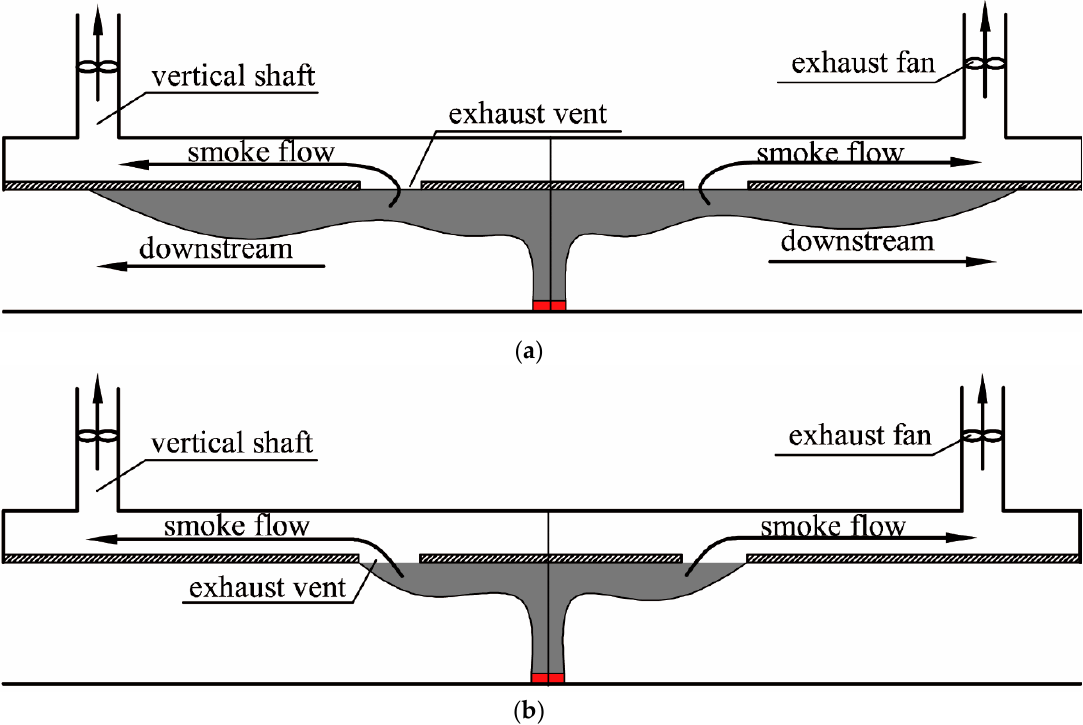
Figure 3. Smoke di ff usion under di ff erent exhaust volumetric flow rates in tunnel. ( a )small exhaust Figure 3. Smoke diffusion under different exhaust volumetric flow rates in tunnel. ( a )small exhaust volumetric flow rate; ( b ) critical exhaust volumetric flow volumetric flow rate; ( b ) critical exhaust volumetric flow rate.